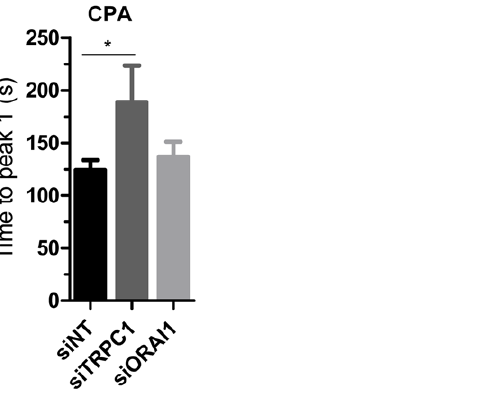
Figure 7. Altered ER Ca 2 + release kinetics with TRPC1 silencing. Quantitation of the time to reach peak cytosolic Ca 2 + (t=0–705 s) with CPA in MDA-MB-468 cells with ORAI1 or TRPC1 silencing. Values show mean 6 S.D. for nine wells from three independent experiments; * P , 0.05 (one-way ANOVA with Bonferroni post-tests).